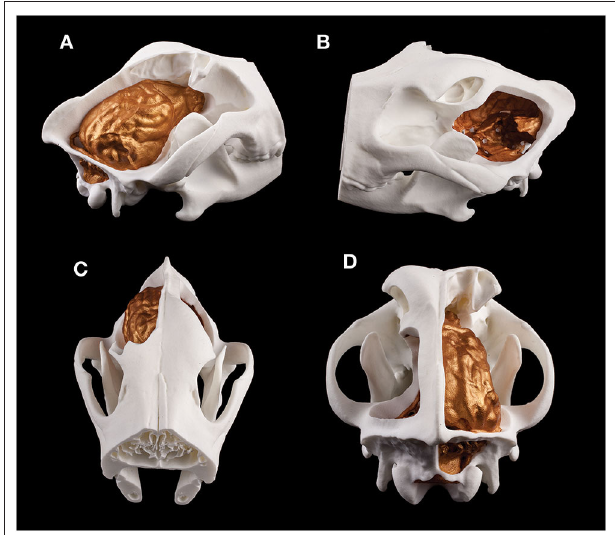
FIGURE 13 | Composite 3D-printed model of a skull and the endocast of a Weimaraner. (A) Right lateral view. (B) Left lateral view. (C) Rostrodorsal view. (D) Caudodorsal view.